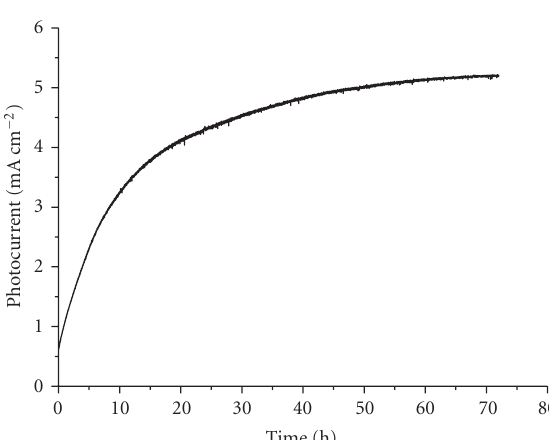
Before After Figure 5: Absorption spectra of a TiO 2 film (3 × 10 − 6 m thick) sensitized with E322 before and after employing the UV-light treatment. SnO 2 glass substrate was used as reference.